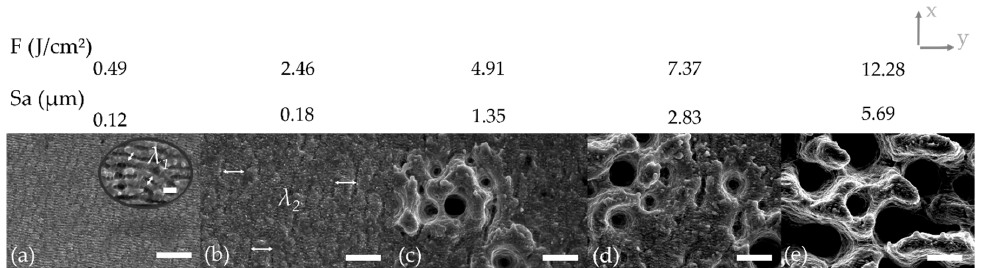
Figure 2. Formation of nano- and microstructures at a PO of 50% and LO of 80% with increasing laser fluence F . The y-axis indicates the scanning direction for the PO. The x-axis indicates the line feed direction for the LO . ( a ) Femtosecond laser-induced periodic surface structures, λ 1 = 0.859 ± 0.056 µm, scale bar 10 µm and in detail 1 µm. ( b ) Micrometric ripples, λ 2 = 5.038 ± 0.829 µm, scale bar 10 µm. ( c , d ) Formation of micro-craters, scale bar 10 µm. ( e ) Pillared microstructures, scale bar 10 µm.